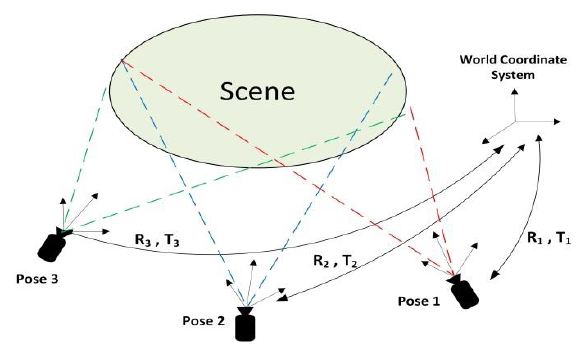
Figure 1. Multi-view camera pose